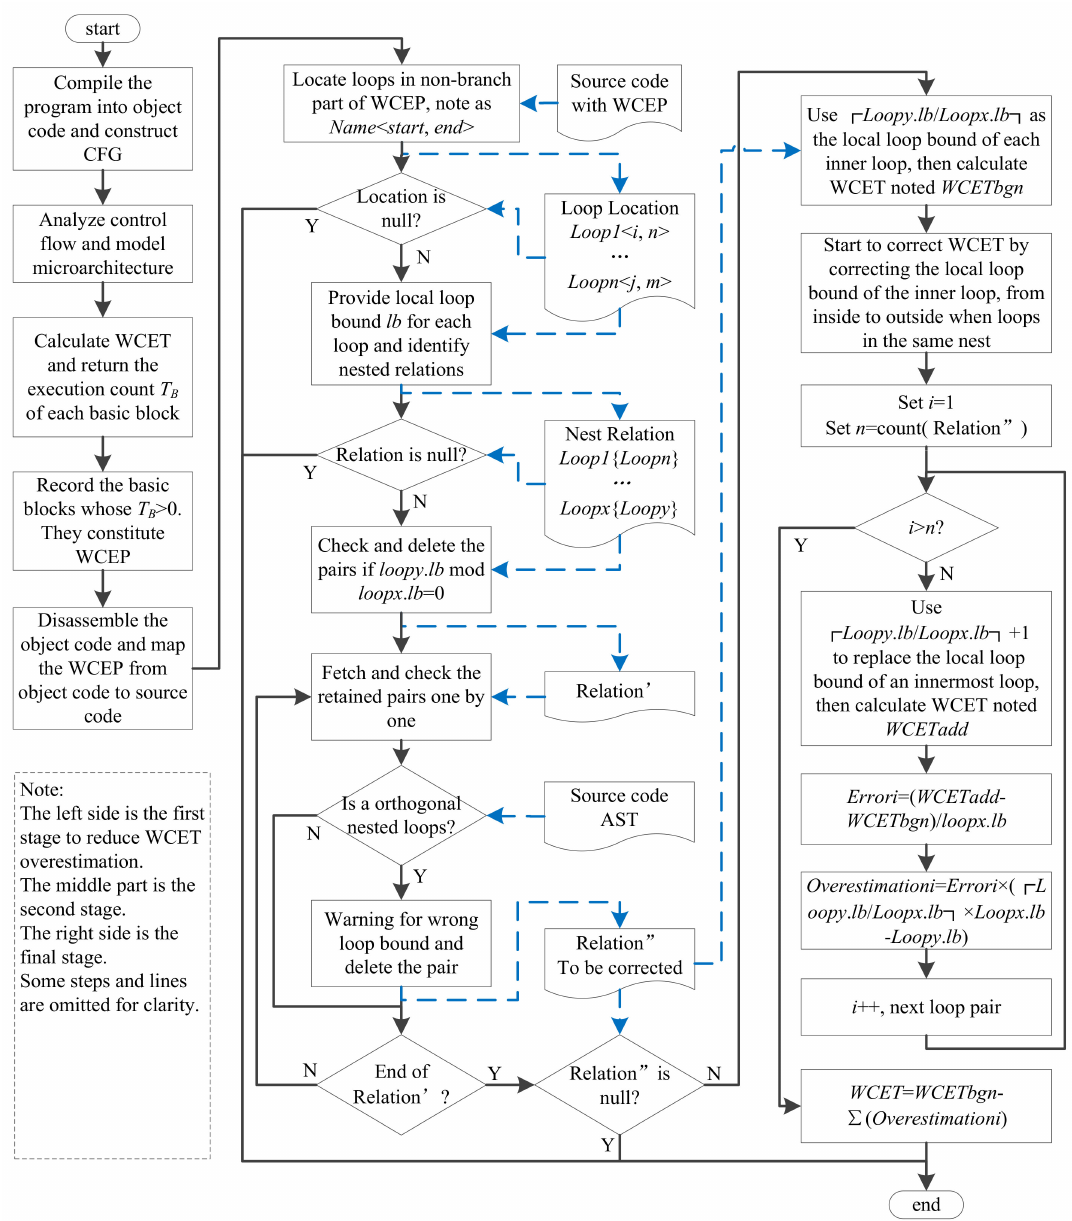
Figure 4. The whole process of WCET overestimation